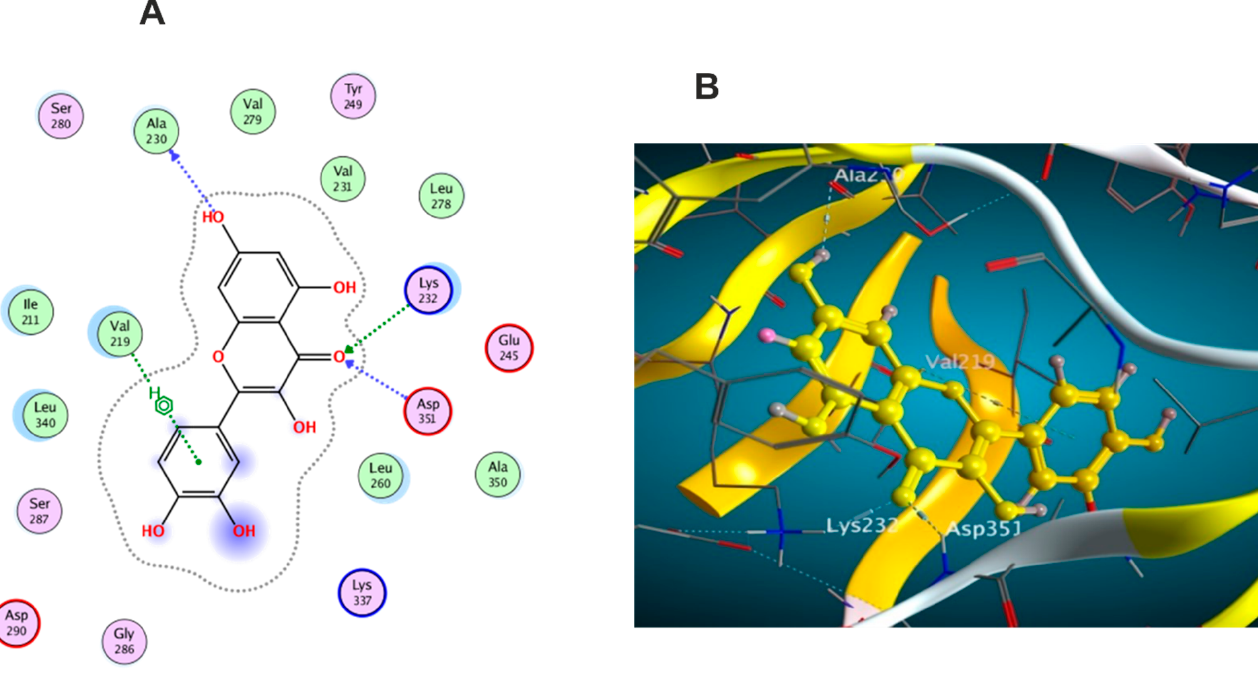
Figure 11. Docking results of compound 3 in the active pocket site of (TGF- β ) (6B8Y): ( A ) 2D interactions of compound 3 ( B ) 3D Docking pose of compound 3 .